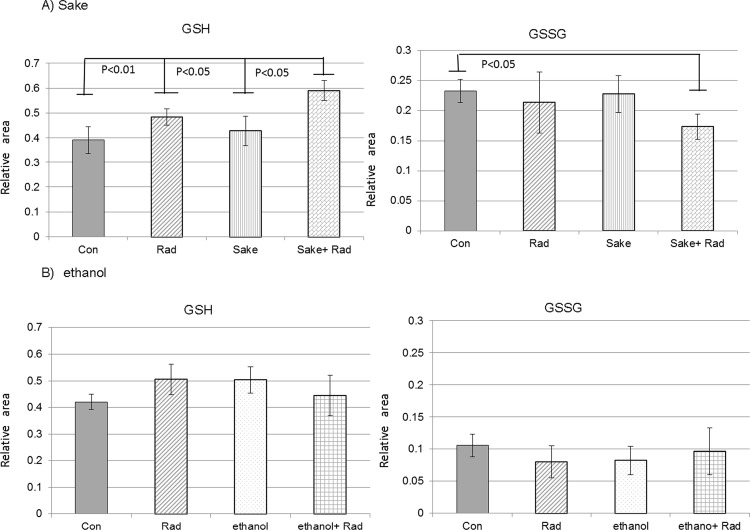
Effects of sake or ethanol on radiation-induced changes of GSH and GSSG in mouse livers.(A) Sake and (B) ethanol. Data are relative area values of the metabolites and are presented as means ± S.D. of triplicate samples. Statistical analyses were performed by Welch’s t-test.